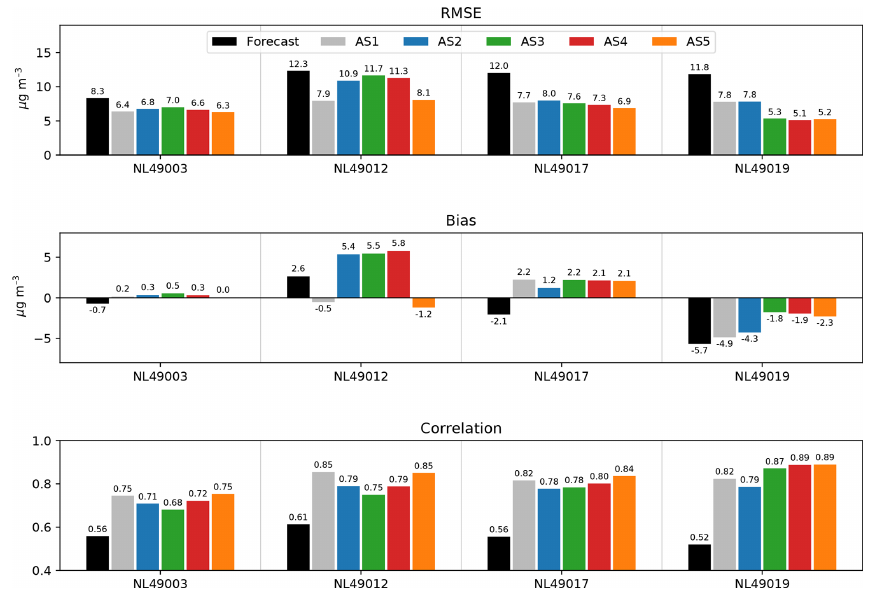
Figure 9. Validation of the model forecast and five different assimilation scenarios at four central reference sites, for the period 15 June to 15 August 2016.